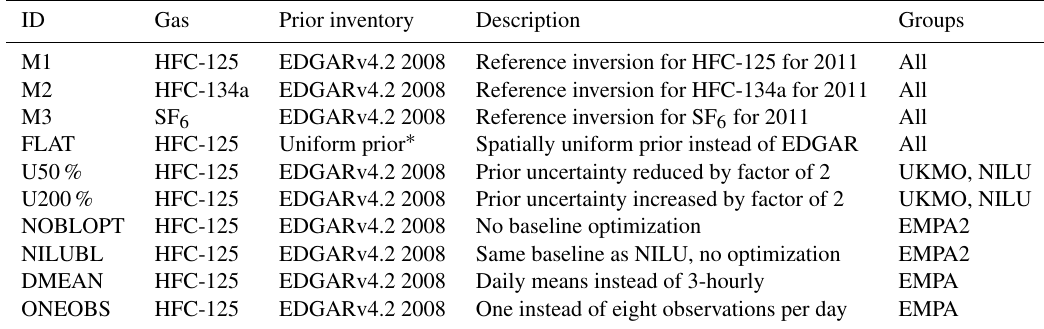
Table 2. Main (M1–M3) and sensitivity inversion